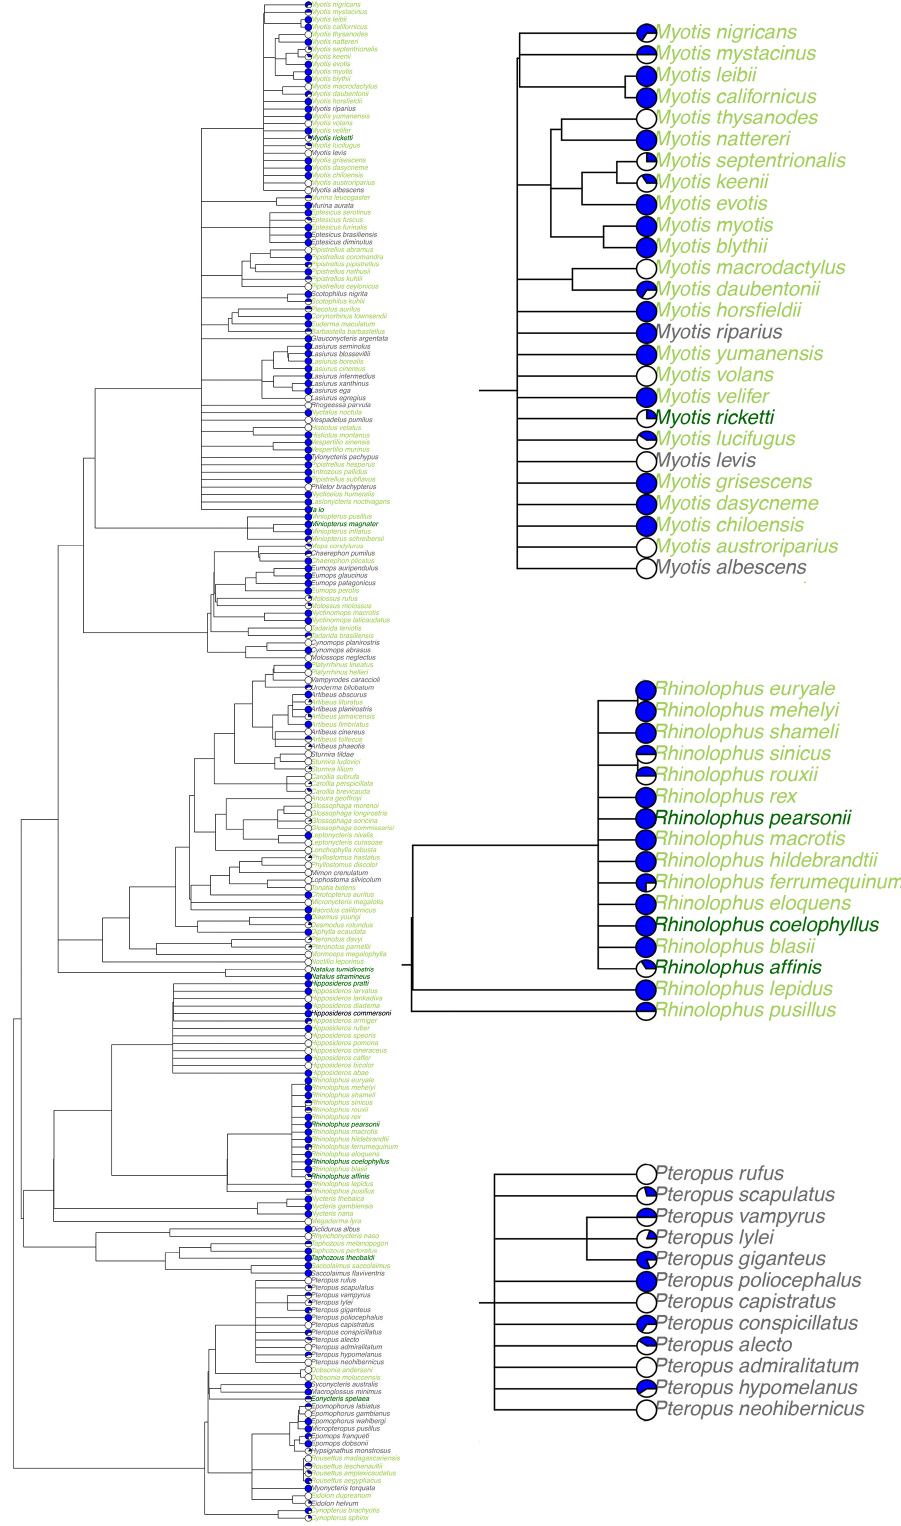
Figure 2. Host phylogeny pruned from the mammalian supertree of ( a ) bat species included in our database ( n = 205), and insets shown for the genera: ( b ) Myotis , ( c ) Rhinolophus , and ( d ) Pteropus . Facultative cave-roosting bat species in light green, obligate cave-roosting species in dark green, and non-cave-roosting species in grey. A pie chart showcasing the proportion of viruses detected in each species via serology (white) or nucleic acid (blue) is next to each